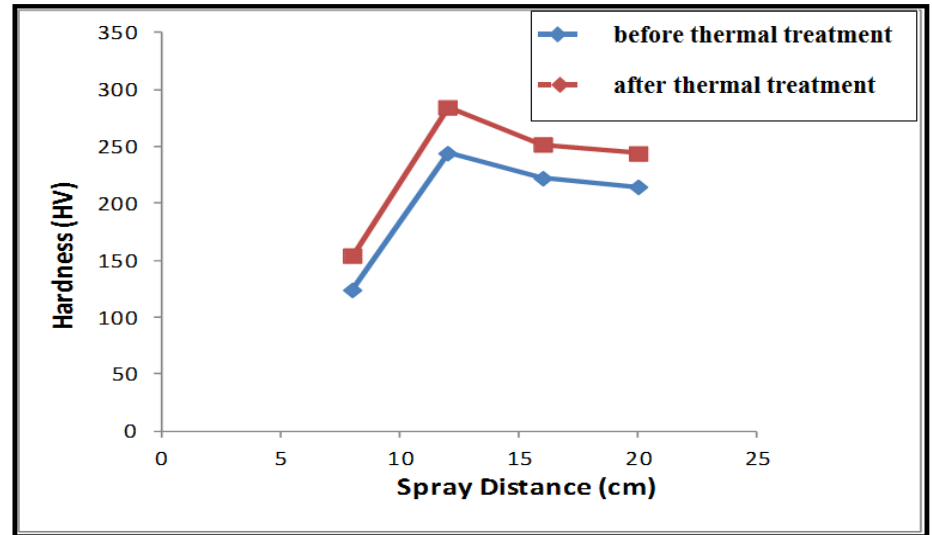
Fig.8: The variation of hardness with spraying distance before and after thermal